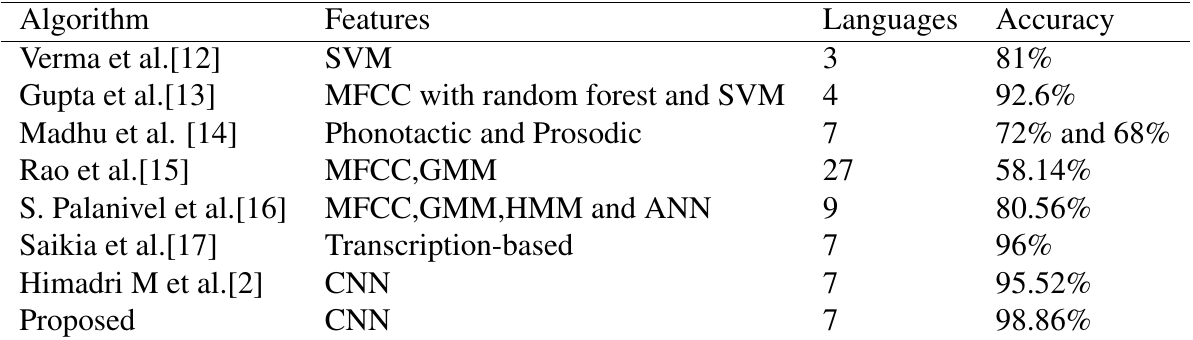
Table 3: Comparison of the proposed approach with existing